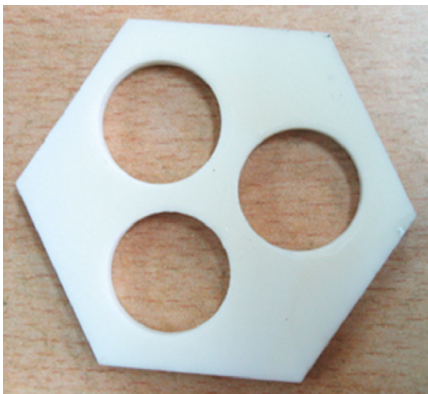
Figure 2: Al 2 O 3 bulletproof ceramic brick drilled.